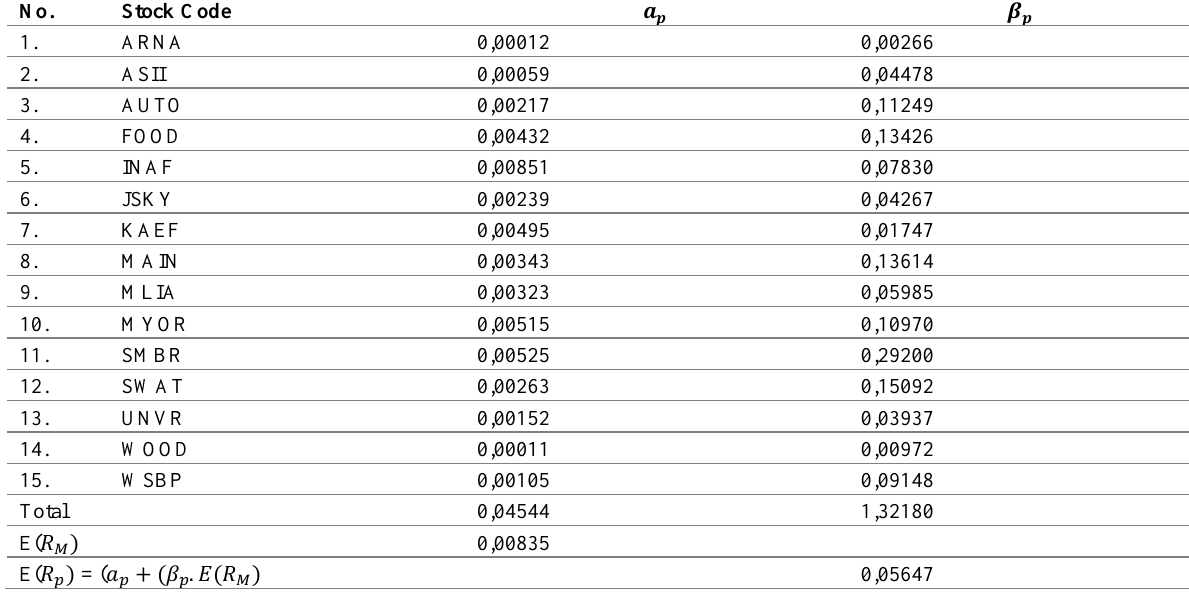
Table 6: Optimal Portfolio Return